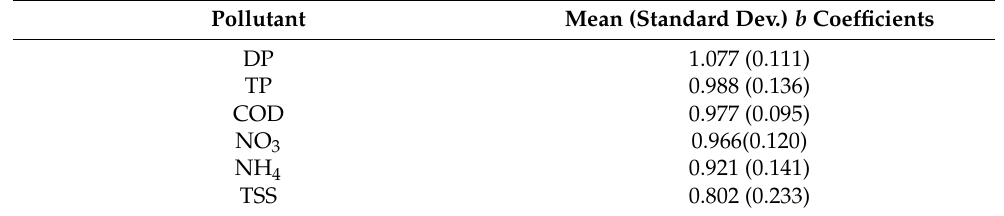
Table 8. Method 3 results